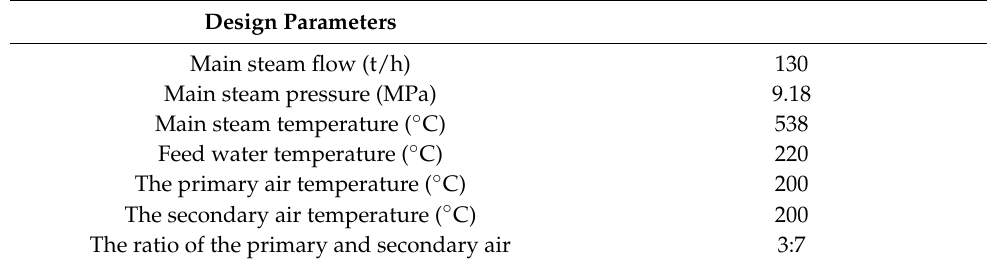
Table 2. The main design parameters of grate boiler.